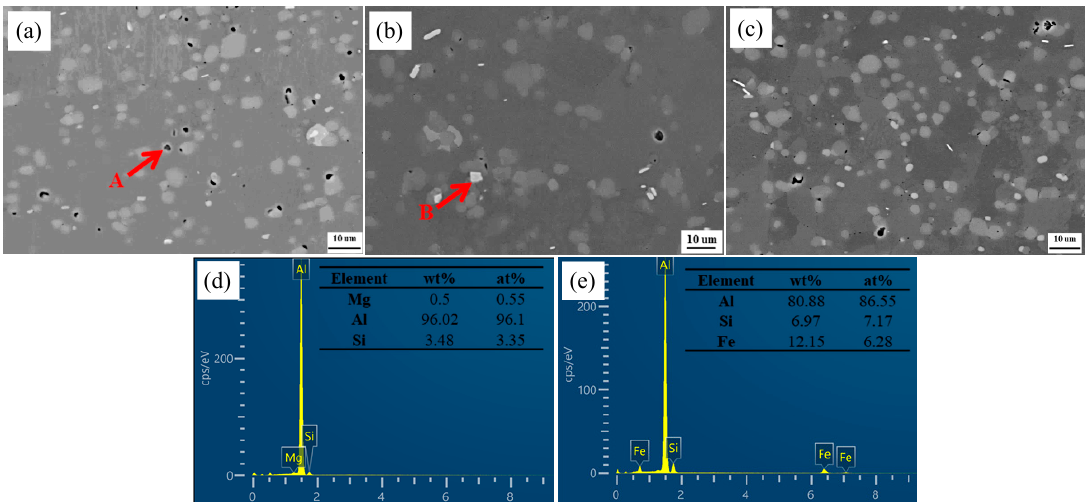
Figure 2. SEM microstructures of base materials (BMs) with different states: ( a ) T1; ( b ) T4; ( c ) T6; ( d ) corresponding energy dispersive spectrometer (EDS) point analysis taken from A second phases in ( a ); ( e ) corresponding EDS point analysis taken from B second phases in ( b ).